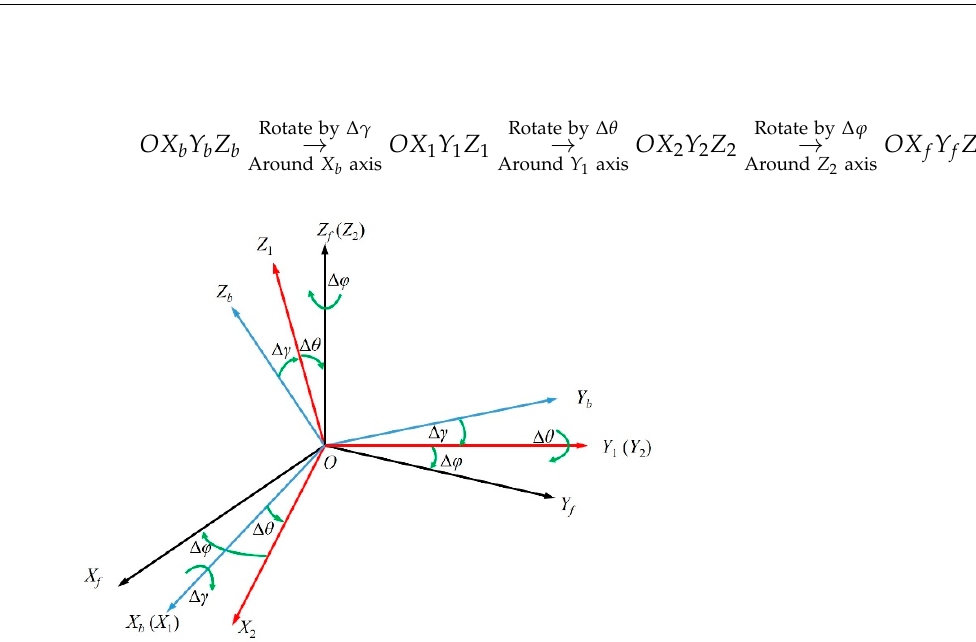
Figure 7. Installation deviation angle of SINS.